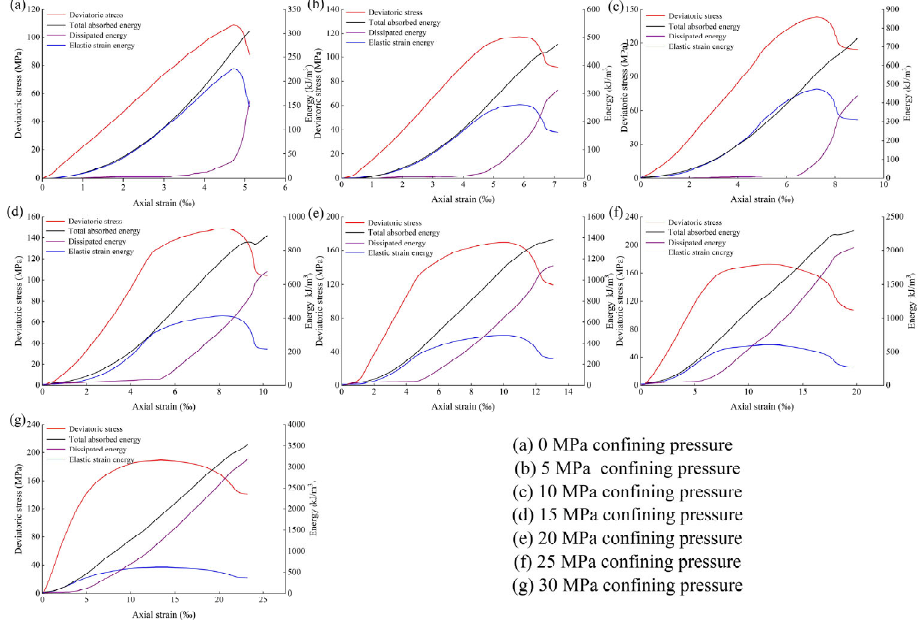
Figure 15. Energy evolution law under different confining pressures.